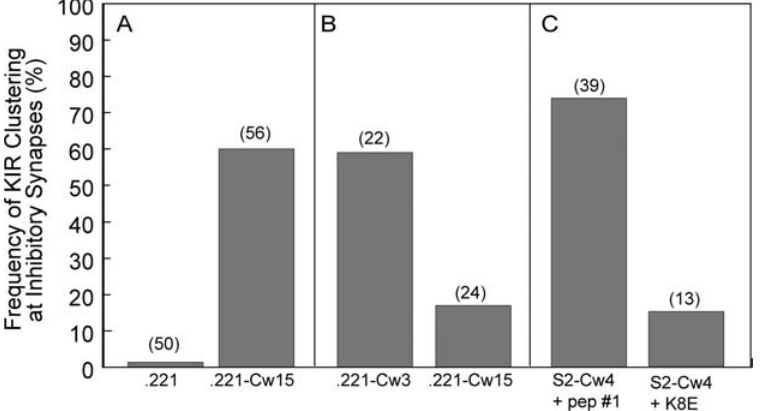
Figure 1. Detection of inhibitory synapses using the cyt42/43 antiserum. IL-2 activated polyclonal human NK cells were mixed with target cells for 10 minutes at 37 u C, fixed, permeabilized and stained with the cyt42/43 rabbit polyclonal antiserum. NK cells and NK:target cell conjugates stained with the cyt42/43 antiserum were scored for KIR clustering. The number of cyt42/43-positive cell conjugates analyzed is given in parentheses over each bar. (A) Mixing with .221 and .221-Cw15 target cells, as indicated. (B) NK cells expressing KIR2DL2 and not KIR2DL1 mixed with .221-Cw3 and .221-Cw15 cells, as indicated. (C) Mixing with S2–Cw4 cells loaded with a peptide that is permissive for KIR2DL1 binding (peptide # 1) or a peptide that is nonpermissive for KIR2DL1 binding (K8E), as